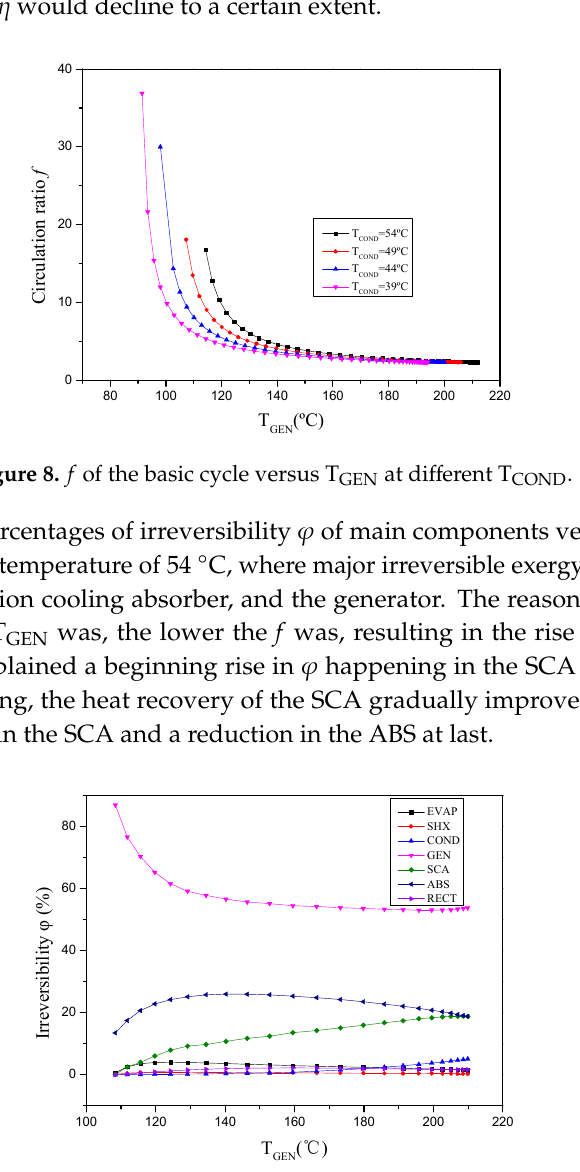
Figure 7. Exergetic efficiency of the basic cycle versus T GEN at different T COND .